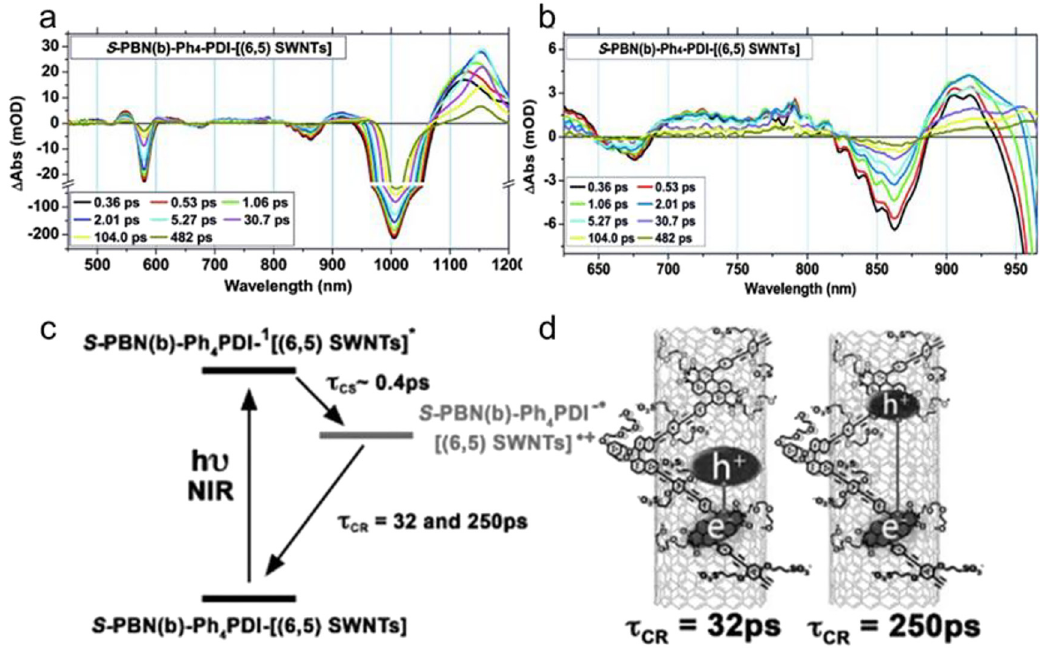
Figure 6: (a) and (b) Representative transient absorption spectra recorded for S-PBN(b)-Ph 4 PDI-[SWNT(6, 5)] samples dispersed in 3:7 MeOH/D 2 O at the time delays noted. λ ex = 1000 nm; (c) Representation of the photoinduced charge separation (CS) and thermal charge recombination (CR) dynamics observed following E 00 → E 11 excitation ( λ ex = 1000 nm) for the S-PBN(b)-Ph 4 PDI-[SWCNT(6, 5)] nanoscale assembly; (d) CR dynamics involving both an intimately associated SWCNT hole polaron and PDI • − and a related charge-separated state involving PDI • − and a SWCNT hole polaron derived from charge migration to an adjacent hole polaron site along the SWCNT backbone [44]. SWCNT, single-wall carbon